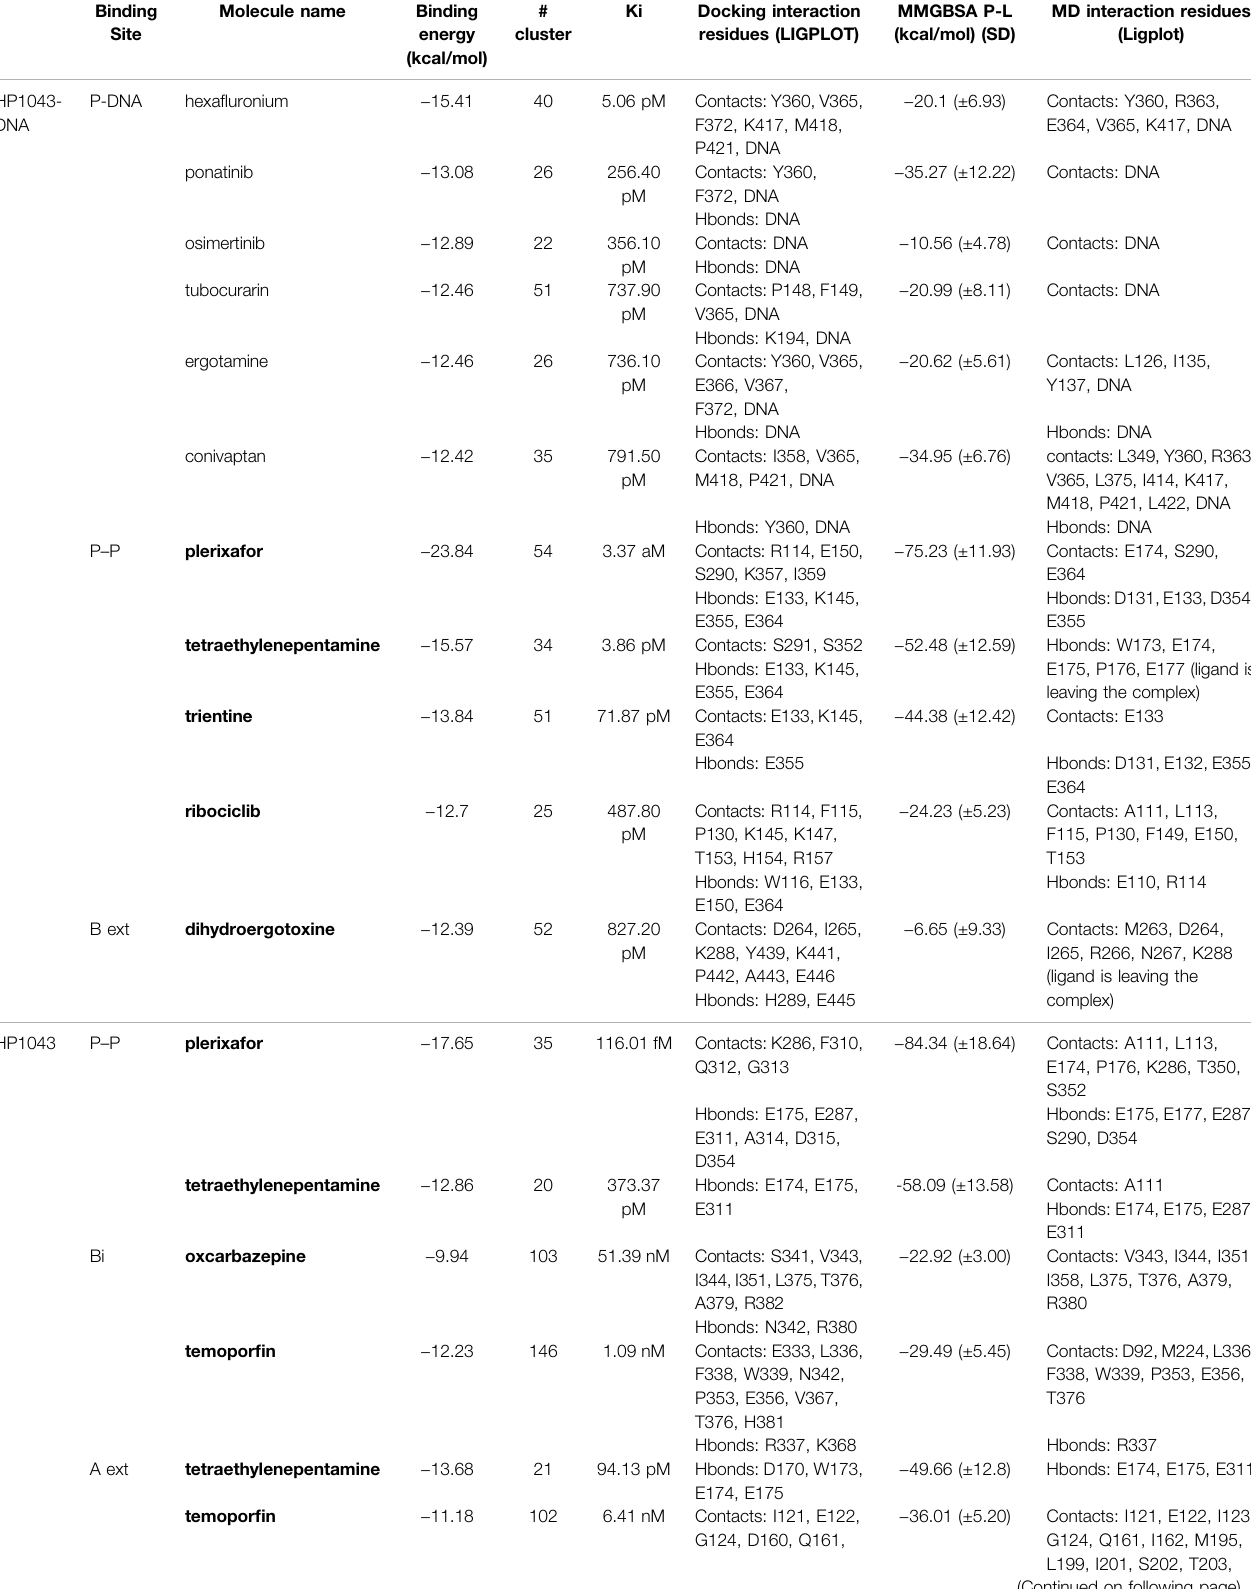
TABLE 2 | HP1043 drug docking and